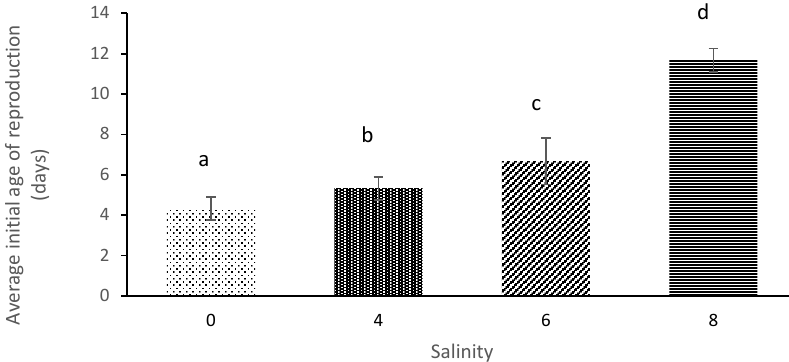
Figure 5. The average initial age of reproduction of M. macrocopa for different salinity treatments. The different small letters indicate significant differences between different salinity treatments ( p < 0.05).